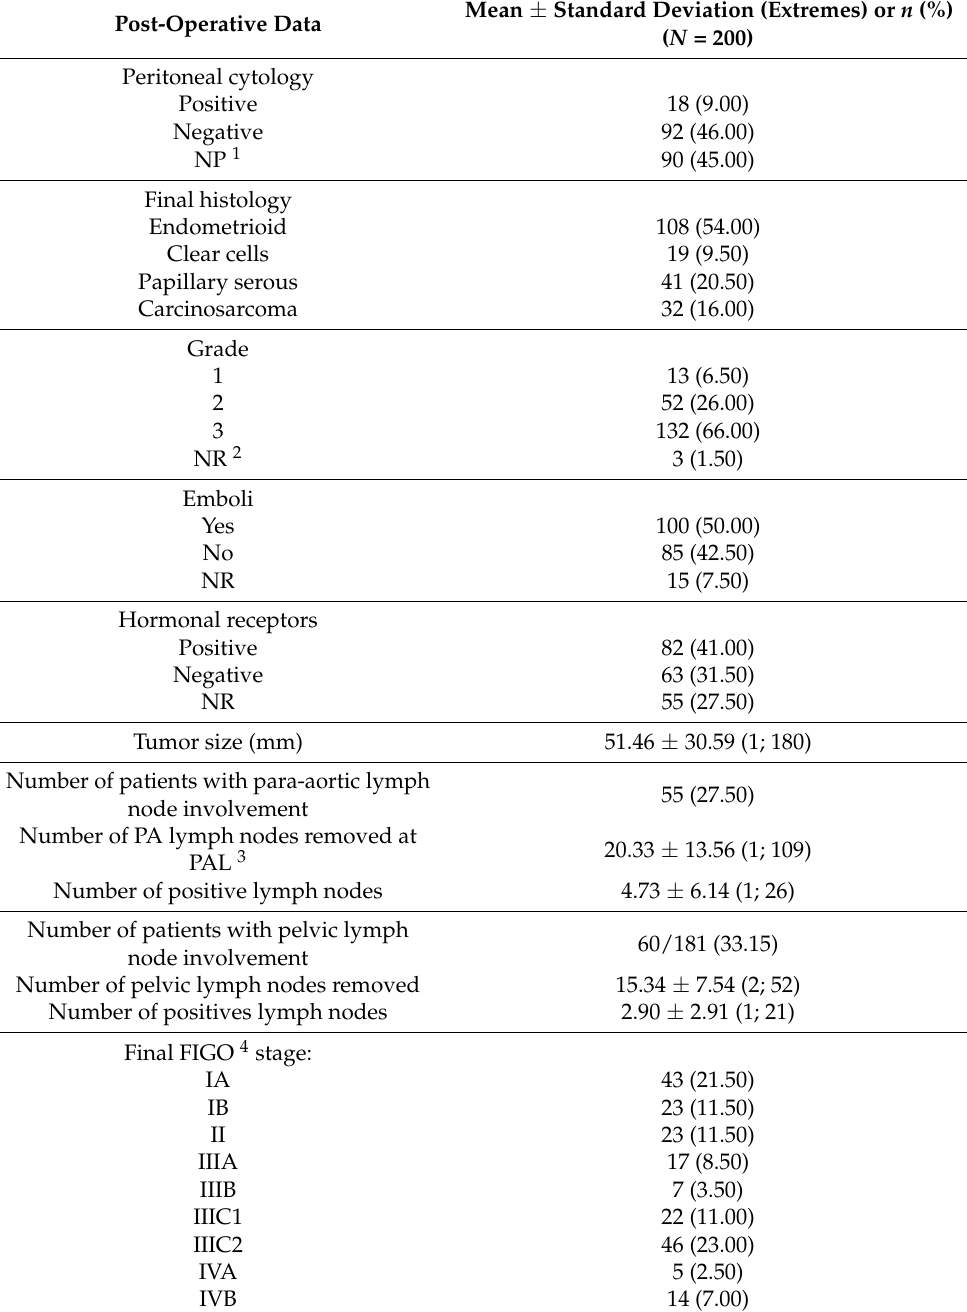
Table 2. Final histological data.